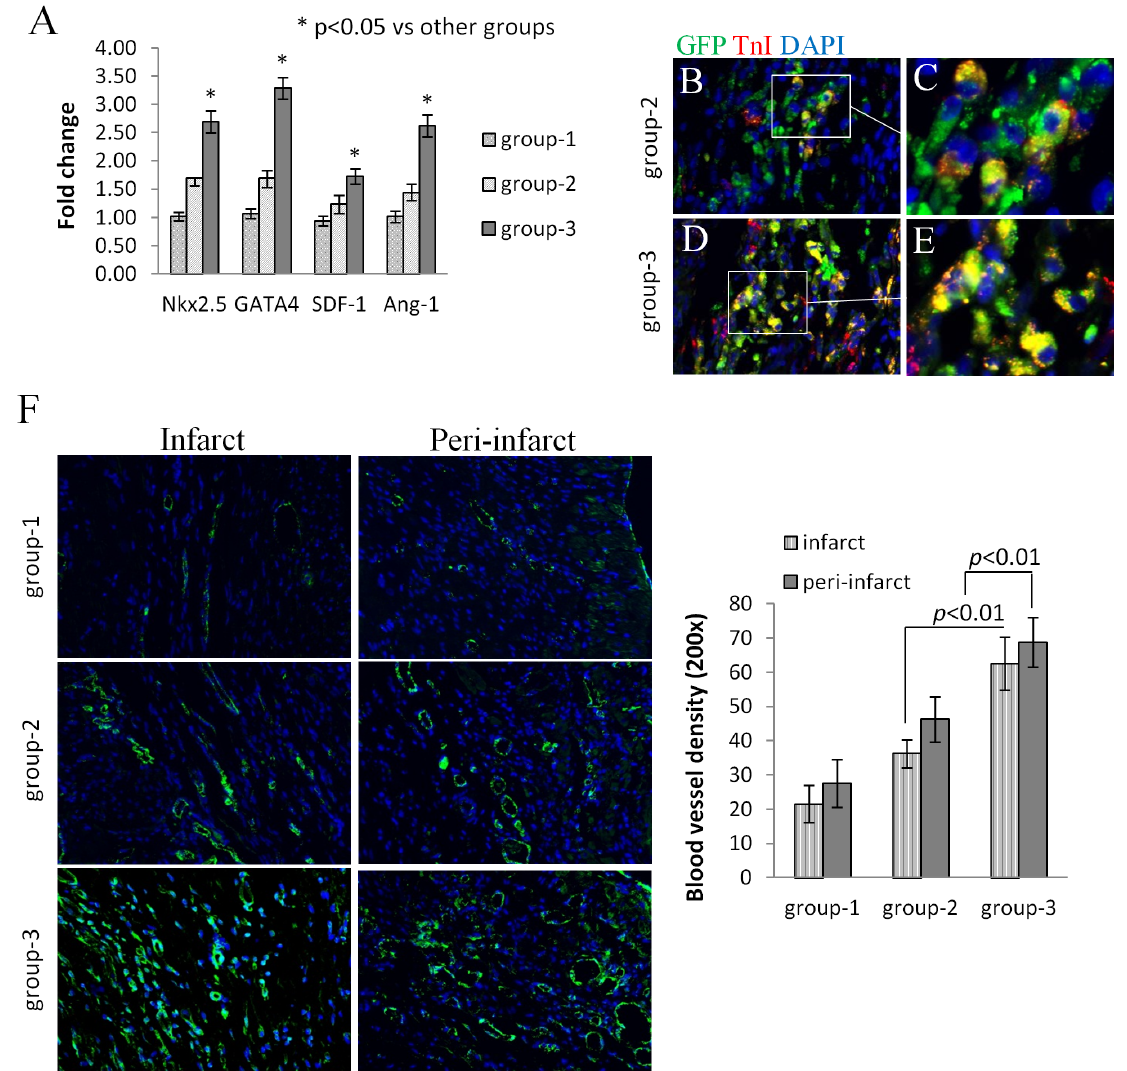
Figure 6. PKG1 a MSCs promoted angiomyogenesis in the infarct hearts. (A) Real time PCR showed a significant increase in cardiac transcription factor Nkx2.5, GATA4 and pro-angiogenic factor SDF-1, Ang-1 genes expression in left ventricle tissue at 3 days after transplantation. (B– E) Double immunostaining for troponin I (red) and green fluorescent protein (GFP, green) on histological sections showed transplanted PKG1 a MSCs differentiated into neofibers more actively as compared to null MSCs at 7 days after transplantation. The nuclei were visualized by staining with DAPI. (E) Fluorescence immunostaining of histological sections from group-2 and group-3 for von Willebrand Factor VIII (green) at 4 weeks after transplantation, blood vessel density was significantly higher in both infarct and peri-infarct regions in group-3 as compared with group-1 and group- 2(P , 0.01).